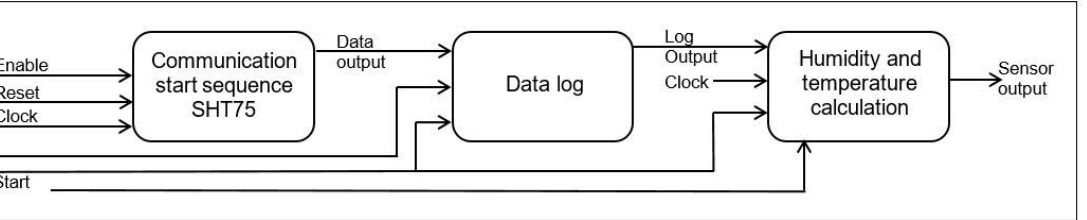
Based on the work presented by Regalado-S á nchez et al. [71] a block diagram of the SHT75 in the FPGA was designed (Figure 10).